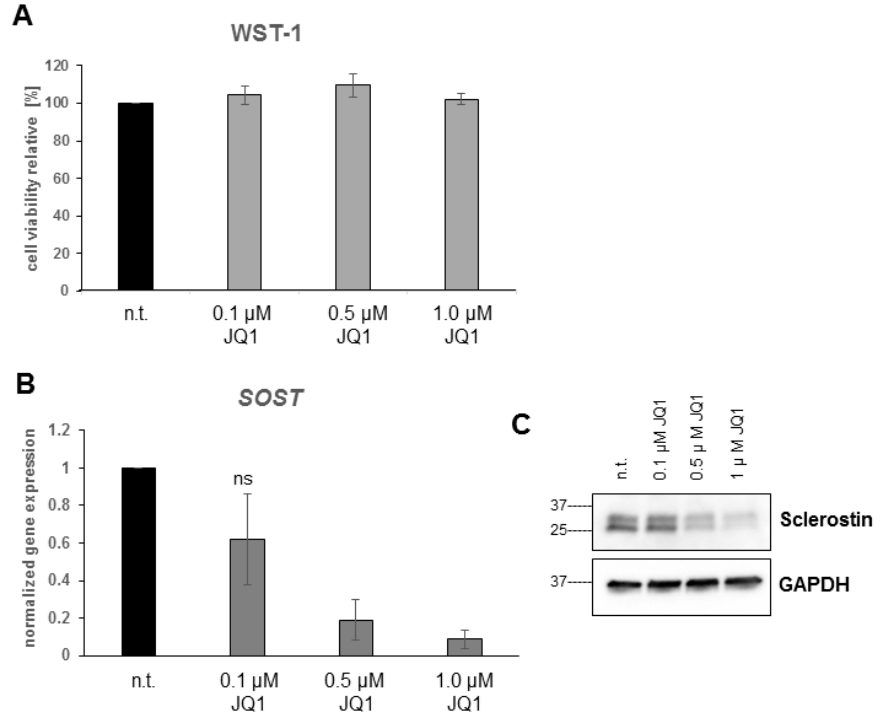
Figure 5. The high affinity bromodomain inhibitor JQ1 decreases sclerostin expression. UMR-106 cells treated for 8 h with a titration of the bromodomain inhibitor JQ1 do not change their metabolic activity ( A ). JQ1 treatment leads to a concentration dependent decrease in SOST mRNA ( B ) and Sclerostin protein ( C ) expression. Error bars indicate standard deviation from three independent experiments. “ns” indicates non-significance at α = 0.05.